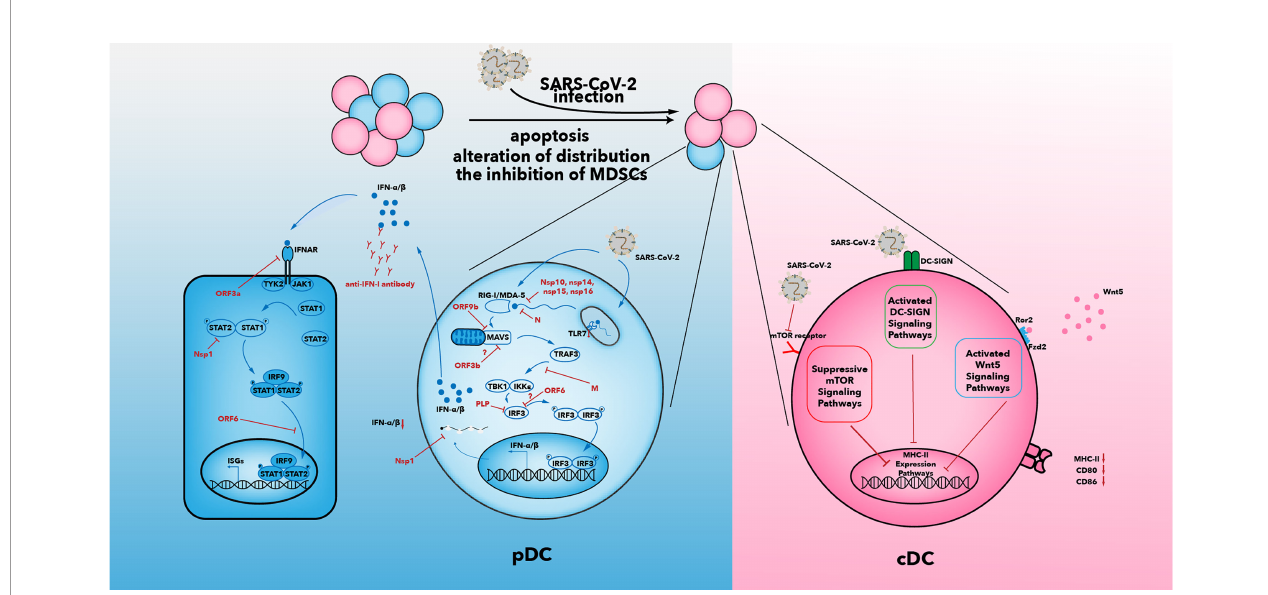
FIGURE 2 | Multiple suppressive mechanisms in SARS-CoV-2-infected DCs from patients with severe COVID-19. The number of DCs in patients decreases after SARS- CoV-2 infection. Increased apoptosis, alterations in distribution of DCs, and inhibition of MDSCs may be associated with a decrease in DC number. IFN-I secretion is inhibited by various viral proteins that have been shown to be effective against IFN-I signaling in SARS-CoV infection (104). In addition to the effects of viral proteins, anti-IFN antibody and reduced expression of TLR7 have been observed in some patients with severe COVID-19. The capability of antigen presentation is impaired in cDC1 and cDC2. Inhibition of the mTOR signaling pathway, activated DC-SIGN pathway, and activated Wnt5 pathway could contribute to downregulation of MHC-II and co- stimulatory molecules. IFN, interferon; IFNAR, interferon alpha and beta receptor; mTOR, mammalian target of rapamycin; I k B, inhibitor of nuclear factor k B; IRF, IFN regulatory factor; ISG, IFN-stimulated gene; JAK, Janus kinase; IKK ϵ , I k B kinase- ϵ ; M, membrane; MAVs, mitochondrial antiviral signaling proteins; N, nucleocapsid; Nsp, non-structural protein; ORF, open reading frame; P, phosphate; DC-SIGN, dendritic cell-speci fi c intercellular adhesion molecule 3-grabbing non-integrin; PLP, papain-like protease; RIG-I, retinoic acid-inducible gene-I; MDA5, melanoma differentiation-associated gene 5; SARS-CoV-2, severe acute respiratory syndrome-coronavirus 2; TANK, TRAF family member-associated NF- k B activator; TBK1, TANK-binding kinase 1; TRAF3, tumor necrosis factor receptor-associated factor 3; STAT, signal transducer and activator of transcription; TYK2, tyrosine kinase 2; Wnt5, Wnt oncogene analog